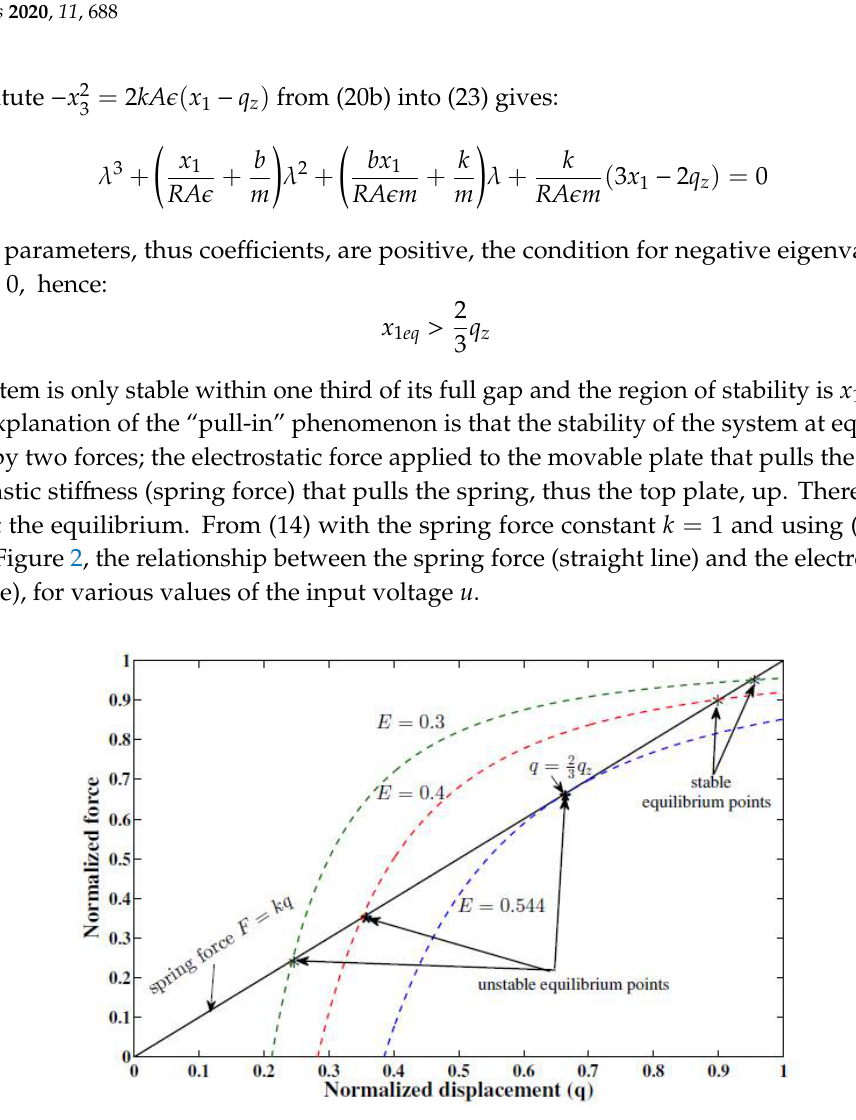
Figure 2. Pull-in displacement characteristic of the microactuator.